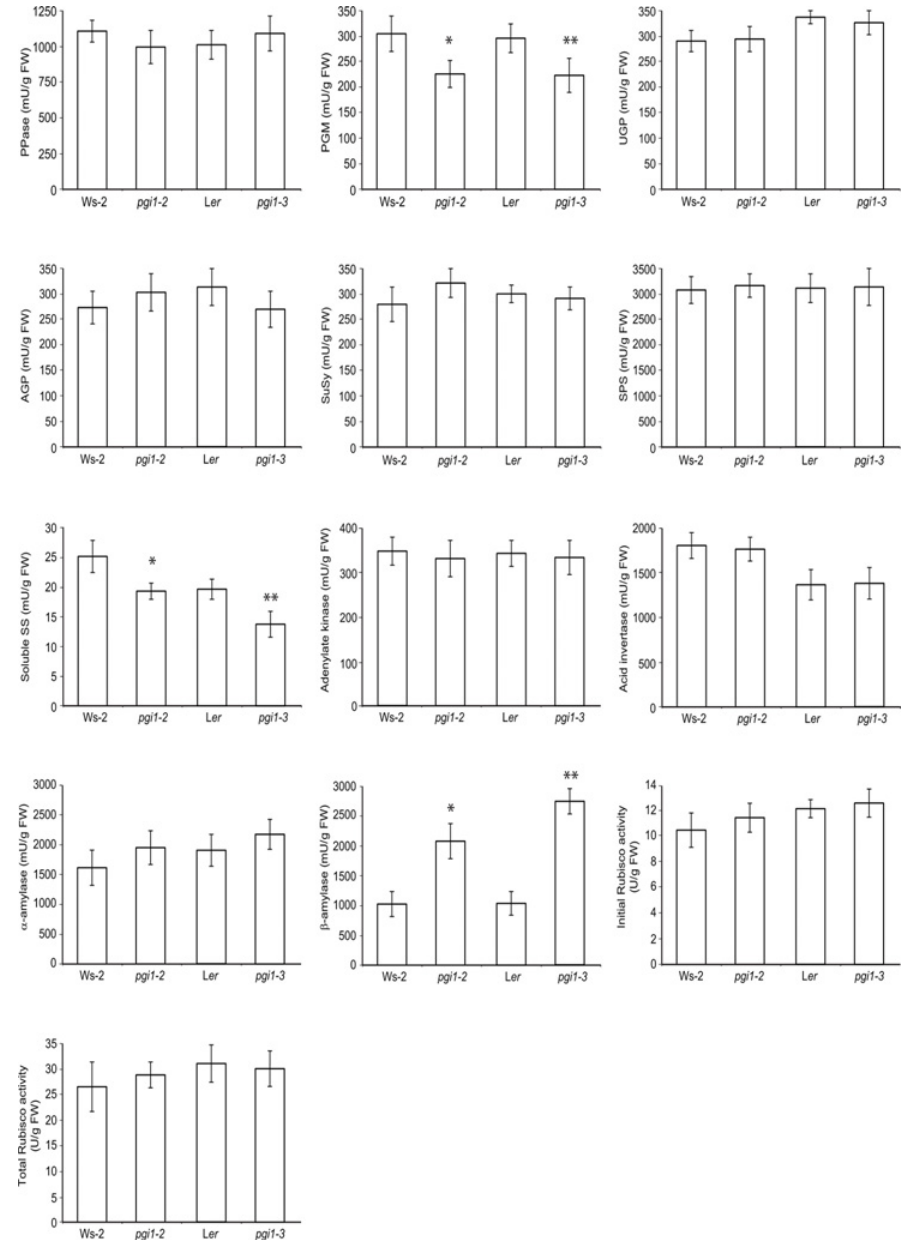
Fig 8. Activities of enzymes closely connected to starch and sucrose metabolism in source leaves of WT (L er and Ws-2), pgi1 – 2 and pgi1 – 3 plants. Plants were cultured on soil under LD conditions. Fully developed, source leaves were harvested from 30 DAG plants after 12 h of illumination. Values represent the mean ± SE of determinations on four independent samples. Asterisks indicate significant differences based on Student ’ s t-tests. ( * P < 0.05, pgi1 – 2 vs. Ws-2; ** P < 0.05, pgi1 – 3 vs. L er